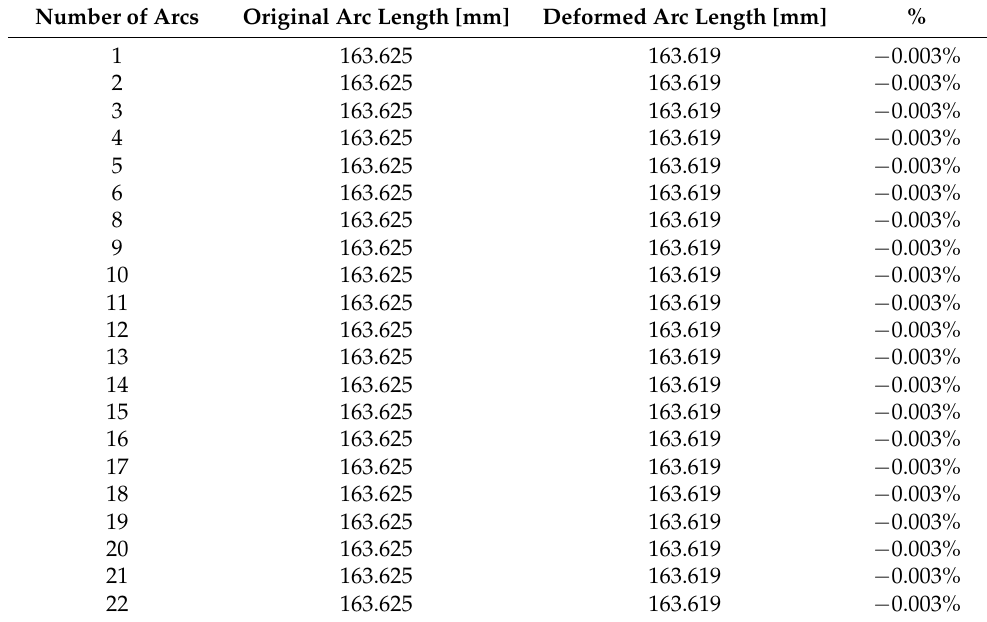
Table A1. Change in arc length of segment